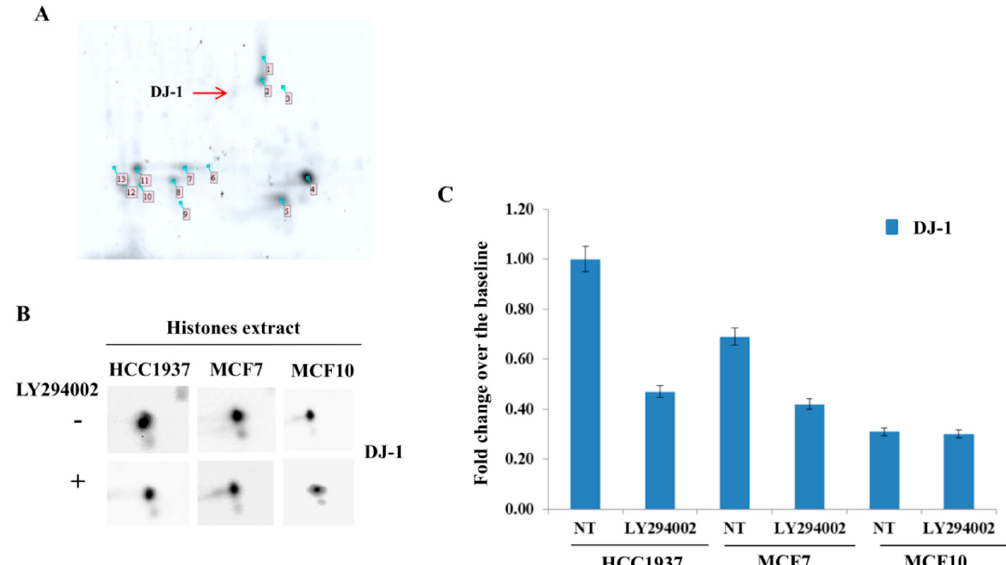
Figure6. Two-dimensionalTAUGelandWesternblotofDJ-1interactingwithhistones. ( A )TAUgelmap of histone isoforms (HCC1937). Histones were resolved coupling TAU gel and SDS-PAGE. Numbered histones spots were extracted and analyzed by mass spectrometry. Experiments are representative of three biologic replicates. Histones protein identifications are reported as Supplementary File S2. The red arrow indicates DJ-1 protein spot that associates with histones; ( B ) 2D TAU Western blot analysis lets to focus that DJ-1 proteoform interacting with histones appears as single spot. The expression levels of DJ-1 associated with histones are much higher in HCC1937 compared to MCF7 breast cancer cells. However, the levels of DJ-1 associated with histone was lower in normal immortalized breast cells (MCF10) compared to breast cancer cells (HCC1937 and MCF7). The assay was repeated in three independent biological replicates; Blot signal was acquired using Alliance 2.7 (UVITEC, Eppendorf, Milan, Italy). Membranes were acquired at 6 s. Treatment with LY294002 (30 µ M) decreases the levels of DJ-1 interacting with histones both in HCC1937 and MCF7 breast cancer cells. Relative densitometry analyses are shown in panel ( C ). Images relative to western signal normalization were provided as Supplementary File